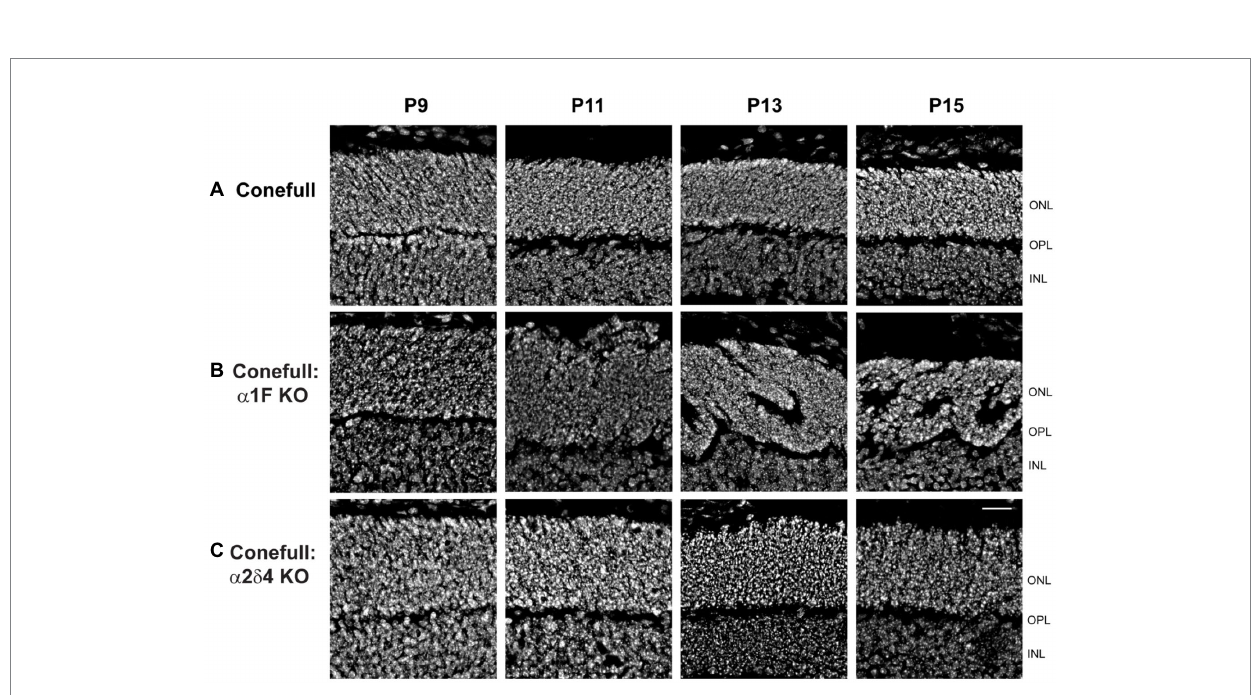
FIGURE 5 Neural rosettes form in Conefull: α 1F KO as cones mature. Retinal cross-sections showing the outer and inner nuclear layers labeled with Hoechst from (A) Conefull, (B) Conefull: α 1F KO, or (C) Conefull: α 2 δ 4 KO at ages P9 - P15. Scale bar is 20 μ